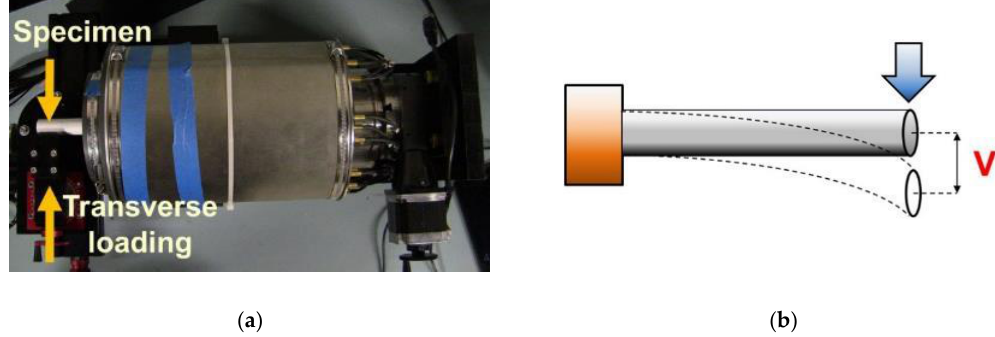
Figure 7. ( a ) The picture of the load frame and ( b ) the schematic shows that transverse loads were applied to the specimen to induce bending.